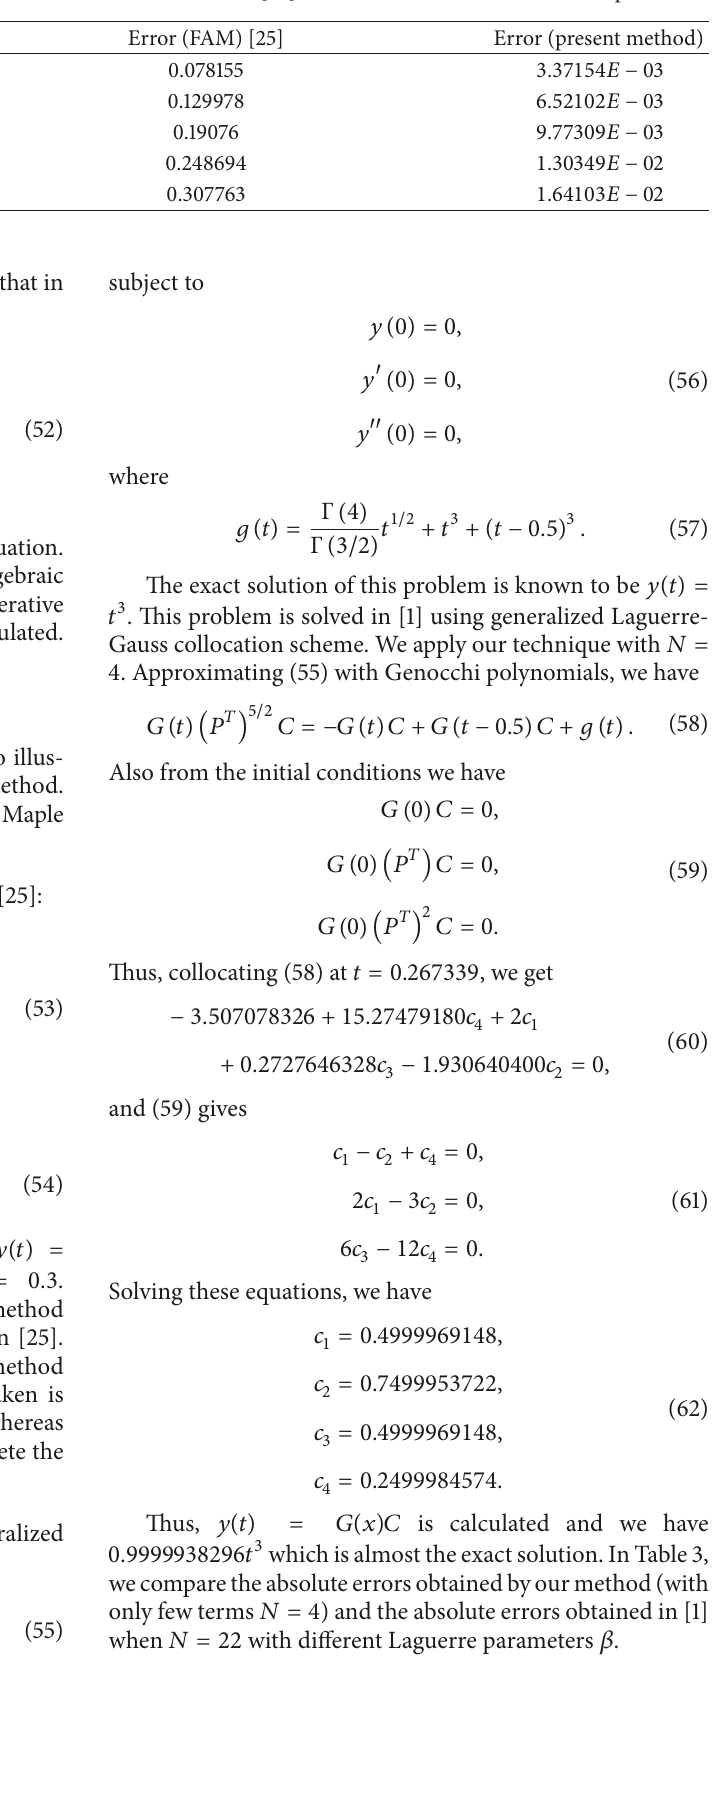
Table 2: Comparison errors obtained by the present method and those obtained in [25] when 𝛼 = 0.6 and 𝜏 = 0.3 for Example